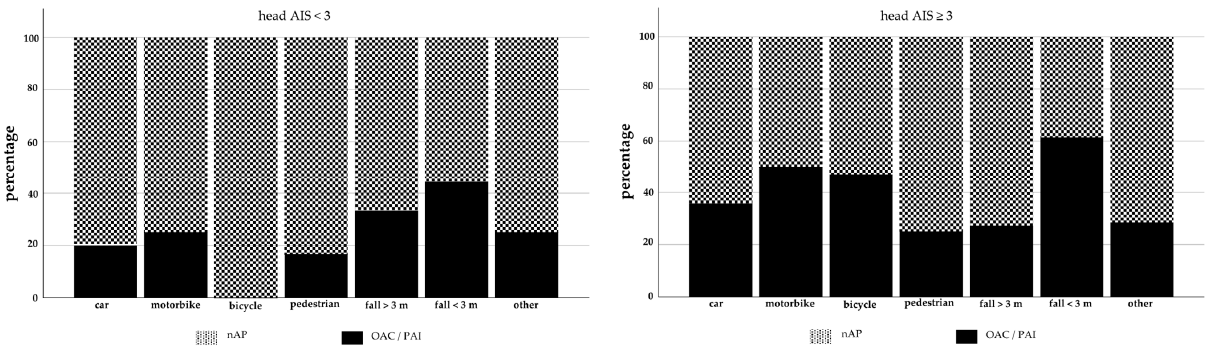
Figure 2. Breakdown in percent of head injuries with and without OAC/PAI depending on AIS head.